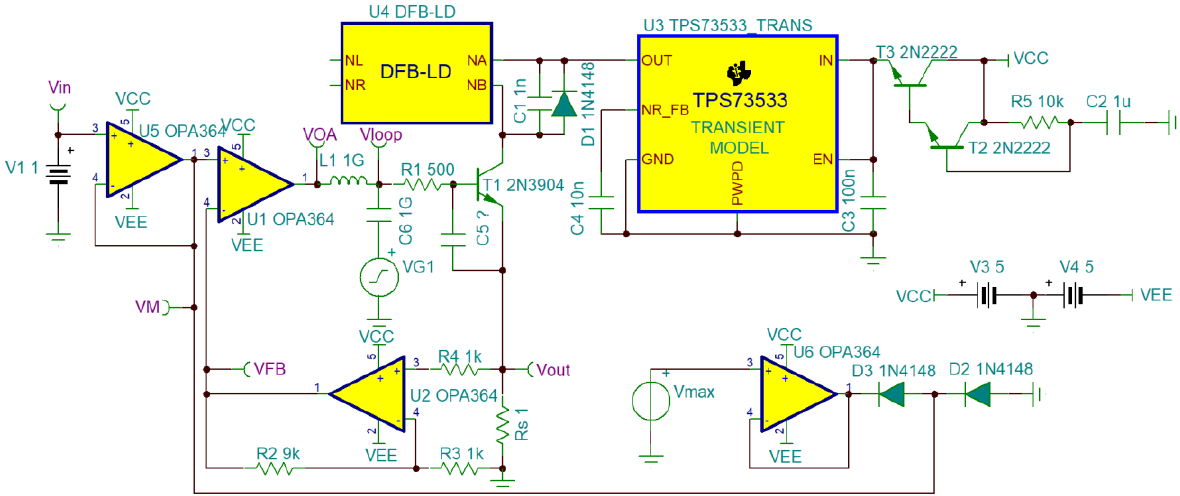
Figure 5. Deformation of the current source for analyzing loop stability.